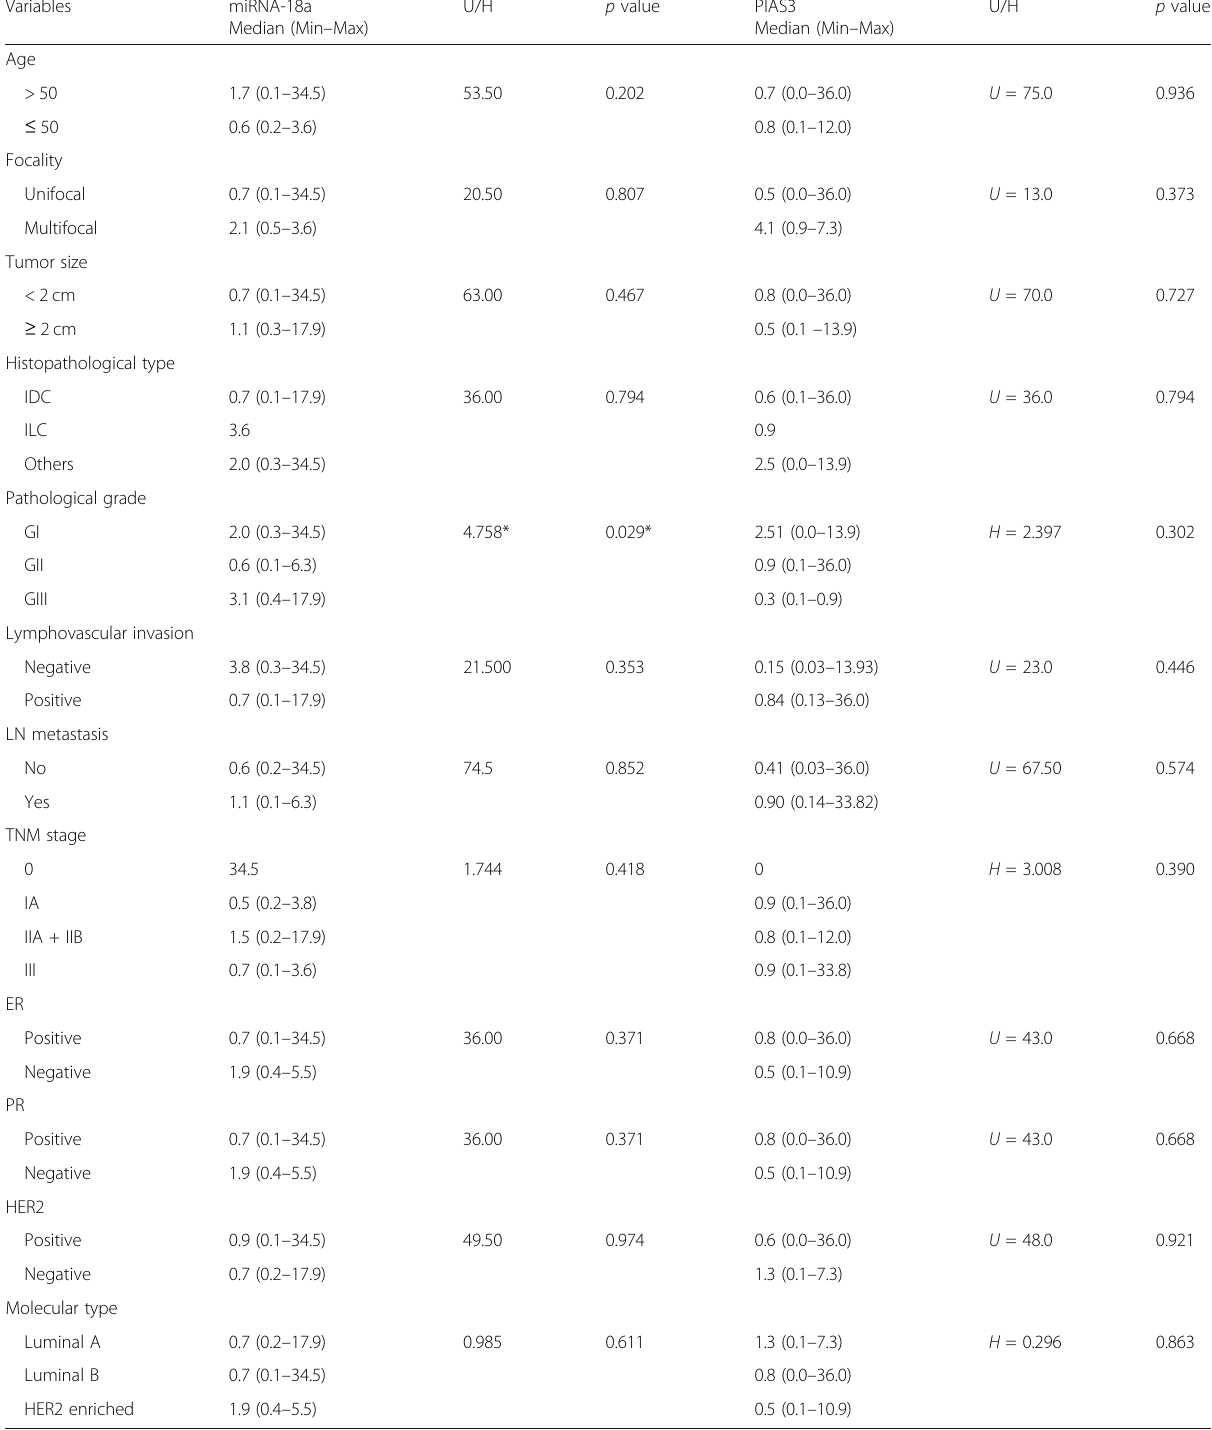
Table 3 Association between PIAS3 fold expression and miRNA-18a fold expression and clinicopathological characteristics of studied